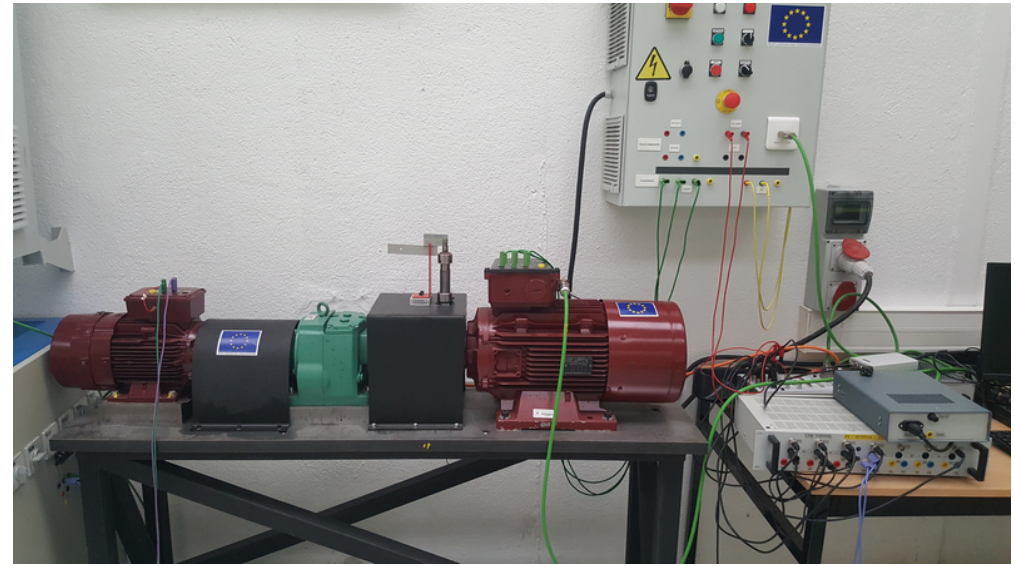
Figure 7. Experimental